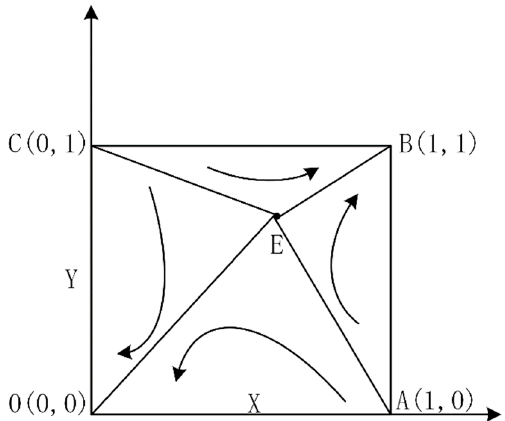
Figure 4. Evolutionary game between SMEs and financial institutions.